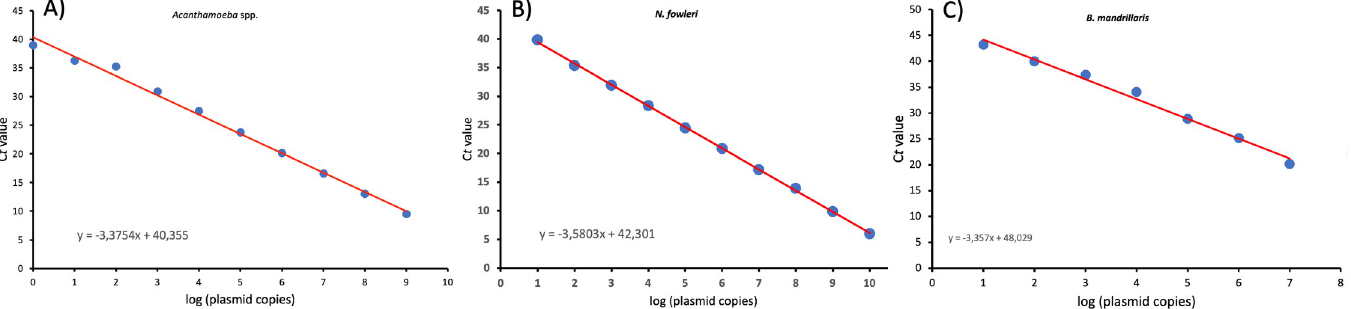
Fig 2. Standard curves were generated by linear regression of the cycle threshold (C t ) versus (A) Acanthamoeba , (B) N . fowleri , and (C) B . mandrillaris plasmid control DNAs.